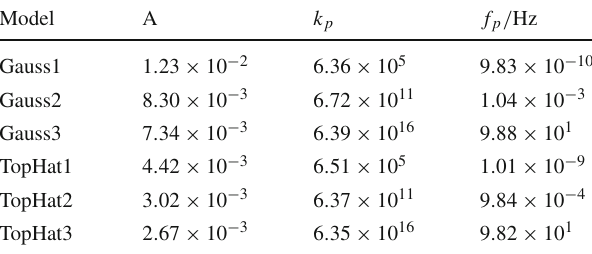
Table 1 The parameter values of the parameterization (32) with α = β = 0 .